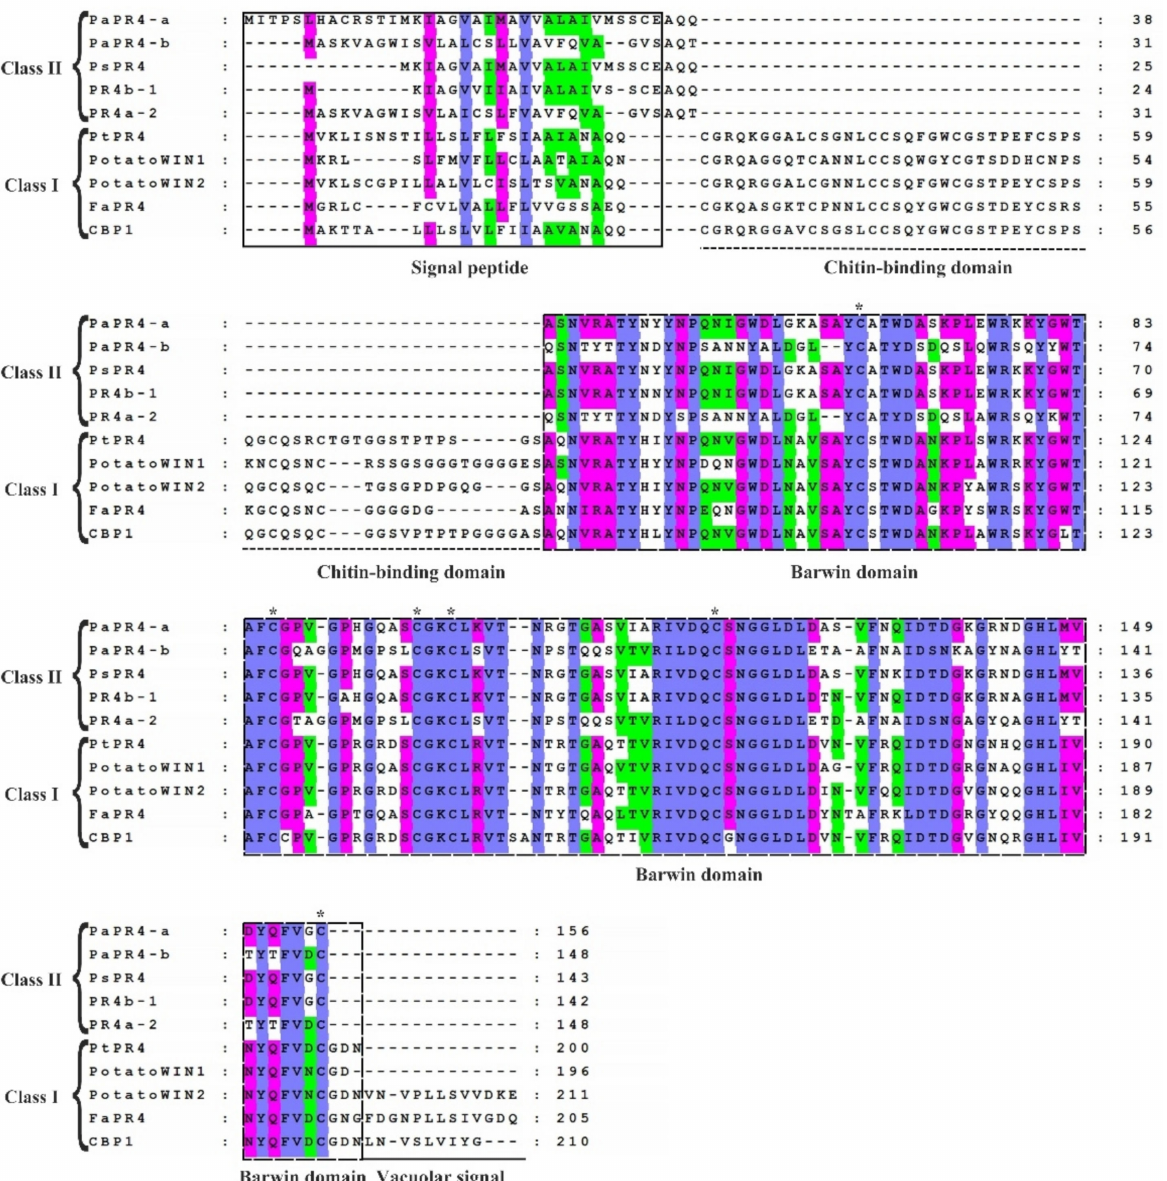
Figure 1. Comparison of the sequences of Class I and Class II PR4 proteins. The sequences of Class I proteins included PtPR4 ( Populus trichocarpa ; GenBank ID: XP_002319077.1), PotatoWIN1 ( Solanum tuberosum L.; GenBank ID: P09761.1), PotatoWIN2 ( So. tuberosum L.; GenBank ID: P09762.1), FaPR4 ( Ficus pumila var. awkeotsang; GenBank ID: ADO24163.1), and CBP1 ( Capsicum annuum ; GenBank ID: AAF18934.1). The sequences in Class II proteins included PaPR4-a, PaPR4-b, PsPR4